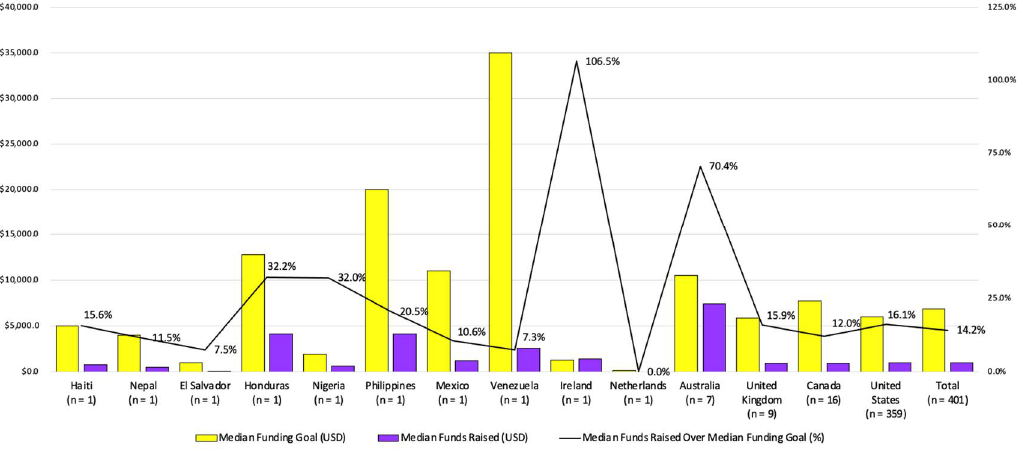
Figure 4. Descriptive Statistics of Donation Pages Organized by